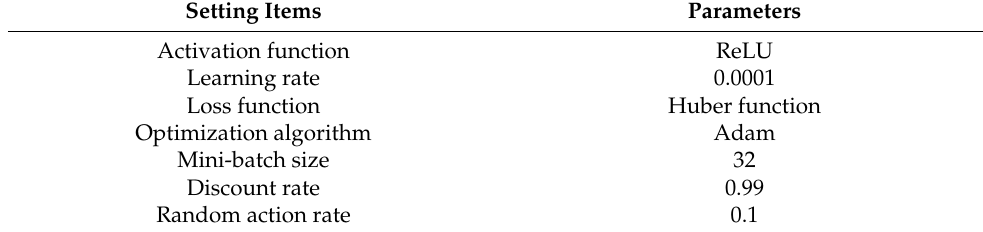
Table 1. Configuration of deep neural network.